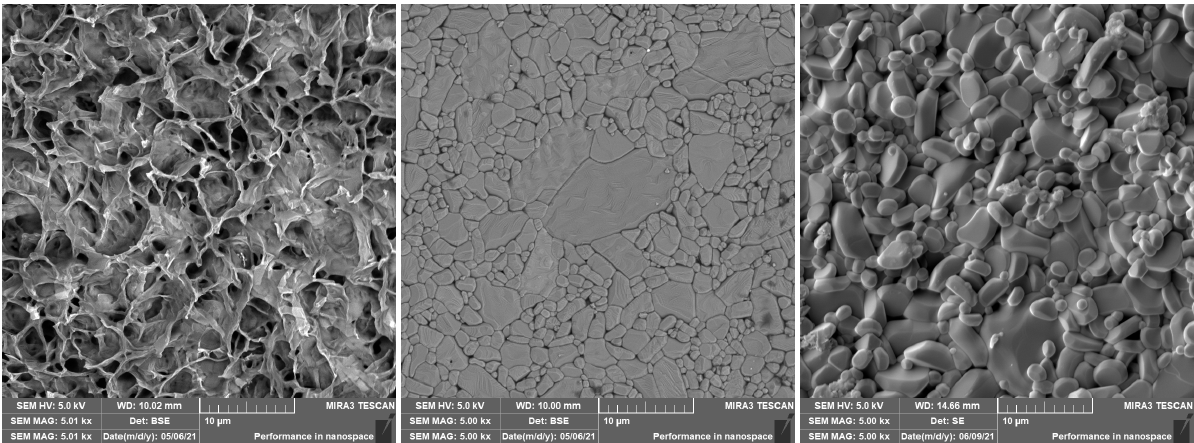
Figure 7. SEM images of: ( left ) the filament, ( middle ) a sintered part, ( right ) a part sintered unsuc- cessfully (sintering process with a low